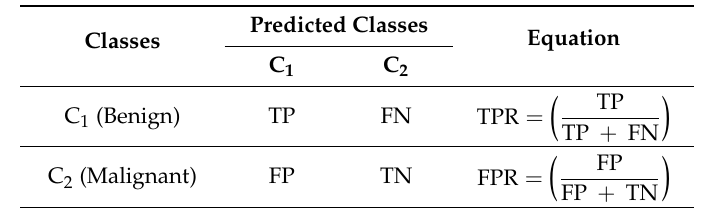
Table 3. Confusion matrix for a binary classifier that is used to distinguish between two classes, namely, negative, TPR: true positive rate, FPR: false positive rate. benign and malignant. TP: true positive; FN: false negative, FP: false positive, TN: true negative, TPR: true positive rate, FPR: false positive rate.